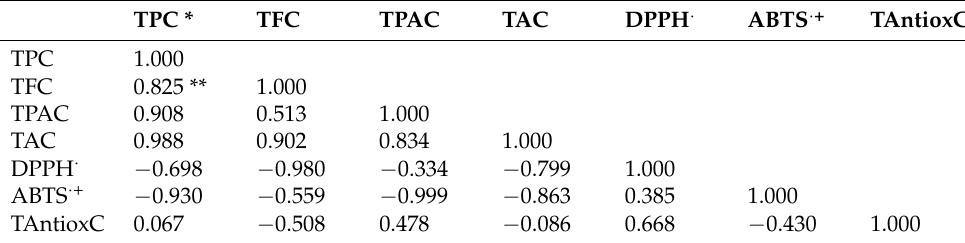
Table 5. Correlation coefficients obtained for relationships between phenolic compounds content and antioxidant activity in M. germanica , P. spinosa and C. monogyna fruit ethanolic extracts. TPC * TFC TPAC TAC DPPH · ABTS · + TAntioxC TPC 1.000 TFC 0.825 ** 1.000 TPAC 0.908 0.513 1.000 TAC 0.988 0.902 0.834 1.000 DPPH · − 0.698 − 0.980 − 0.334 − 0.799 1.000 ABTS · + − 0.930 − 0.559 − 0.999 − 0.863 0.385 1.000 TAntioxC 0.067 − 0.508 0.478 − 0.086 0.668 − 0.430